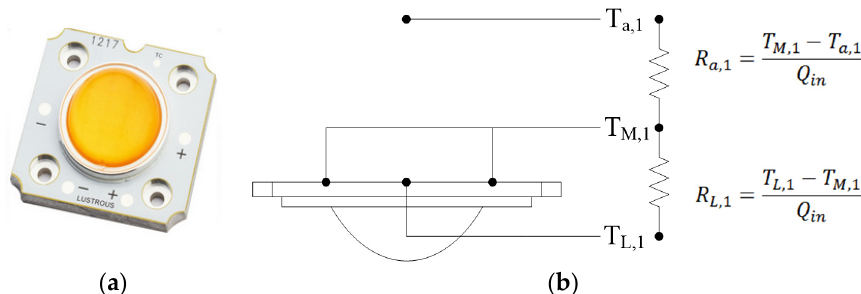
Figure 5. LED Module network. ( a ) HI-LED, ( b ) Thermal resistance network.